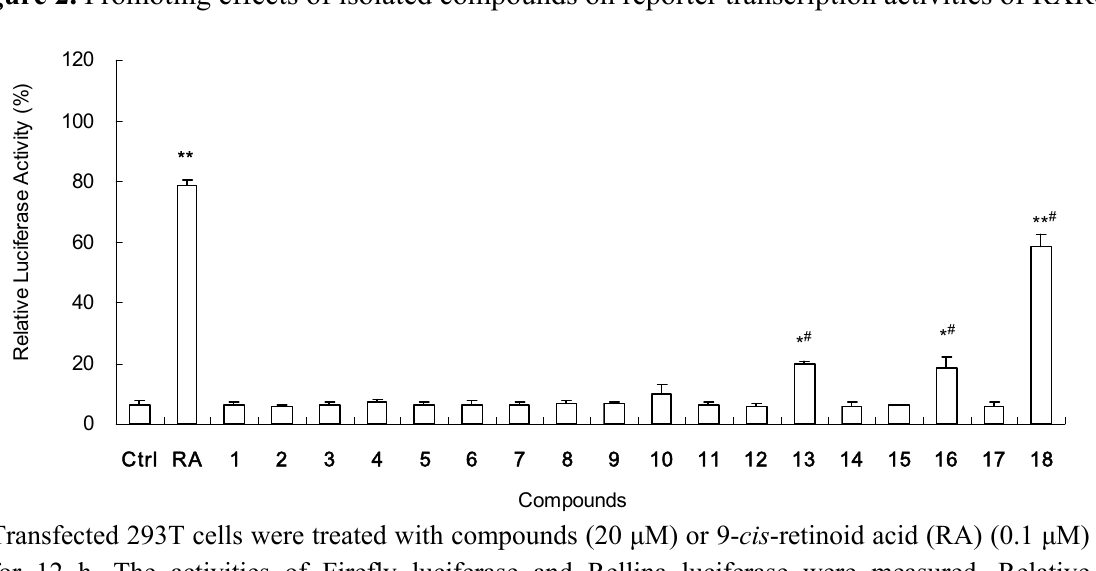
Figure 2. Promoting effects of isolated compounds on reporter transcription activities of RXR α